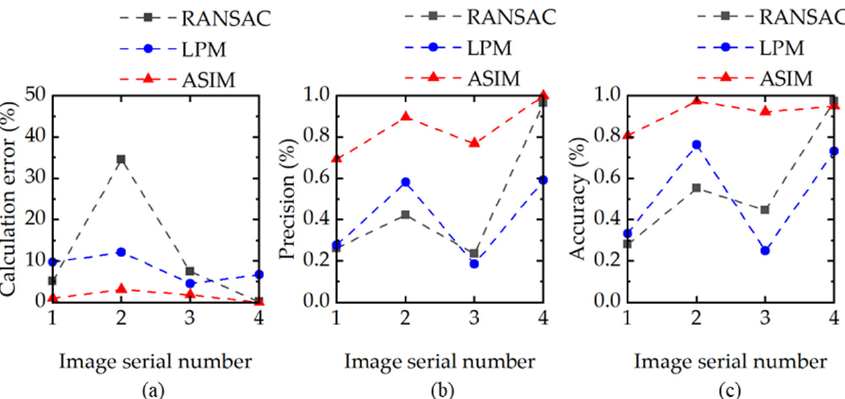
Figure 4. Evaluation of features eliminated by RANSAC, LPM, and ASIM. ( a ) Average error of projection alignment. ( b ) Precision of the elimination feature, which represents the correct proportion of the refined feature points. ( c ) Accuracy of the elimination feature, which represents the correct proportion of all the predicted points.